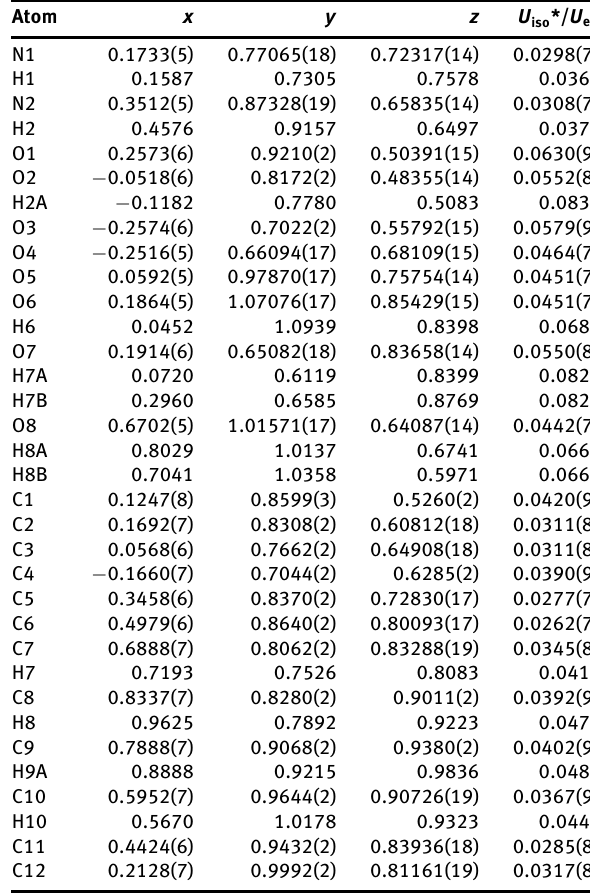
Table 2: Fractional atomic coordinates and isotropic or equivalent isotropic displacement parameters (Å 2